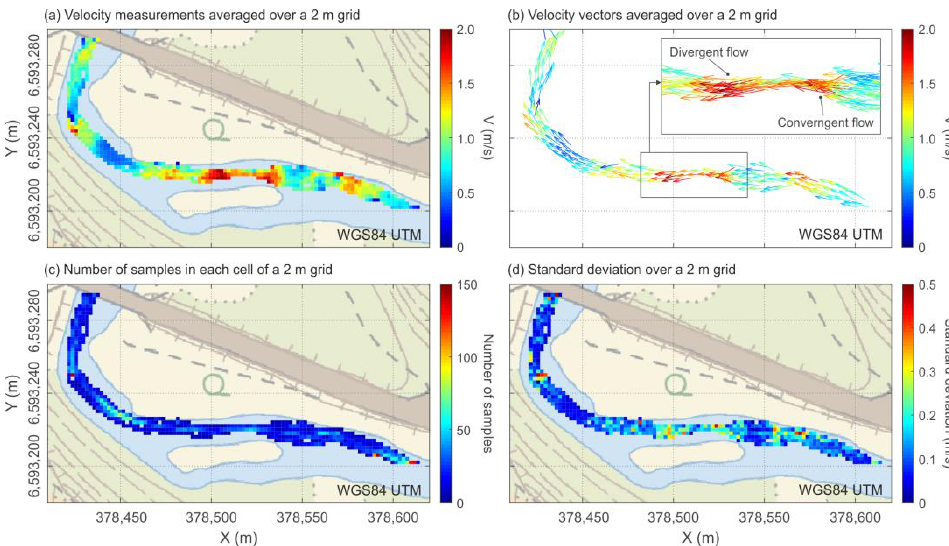
Figure 6. Integration of the nine independent tracks of the drifters. ( a ) Velocity measurements averaged over a 2 m by 2 m rectangular cell grid. ( b ) Velocity vectors averaged over a 2 m by 2 m rectangular cell grid. ( c ) Number of samples in every 2 m by 2 m rectangular cell grid. ( d ) Standard deviation in every 2 m by 2 m rectangular cell grid.